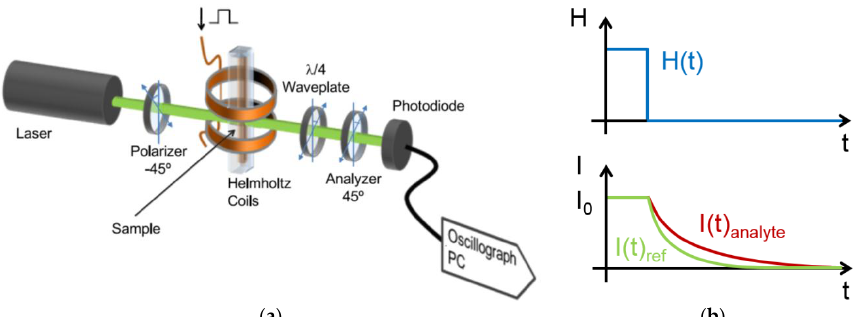
Figure 16. ( a ) Sketch of a typical setup for magneto-optically (Cotton-Mouton effect) measuring changes in the relaxation time of magnetic particles. Graph reproduced with permission from [262].